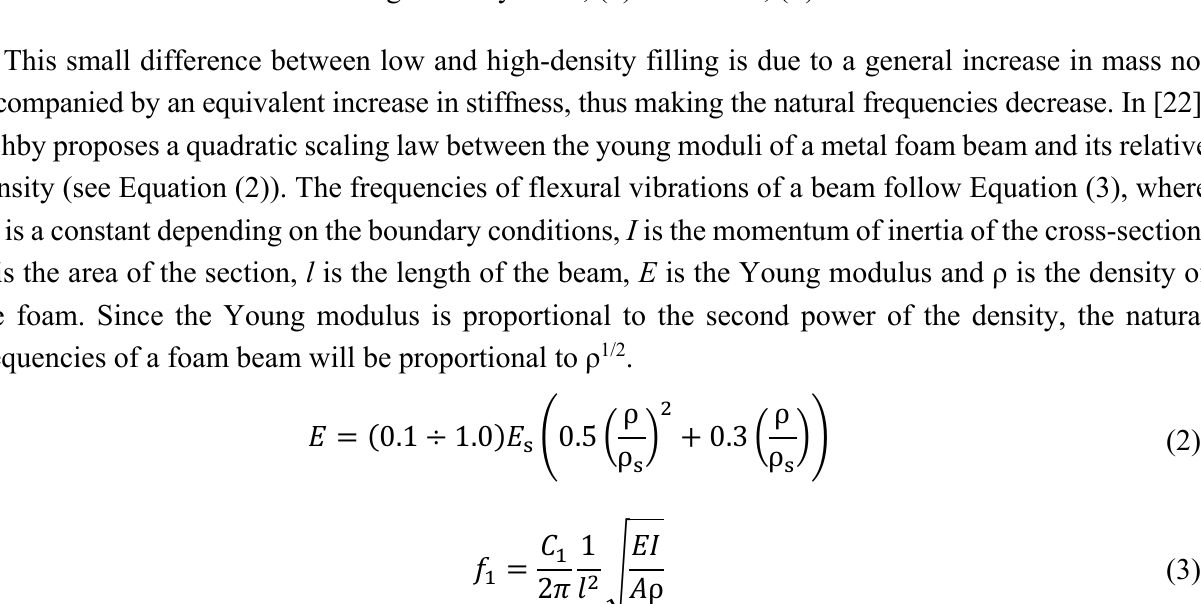
Figure 7. Shape of vibration modes (dimensionless displacement vectors) for a glued interface tube filled with a high-density foam; ( a ) first mode; ( b ) second